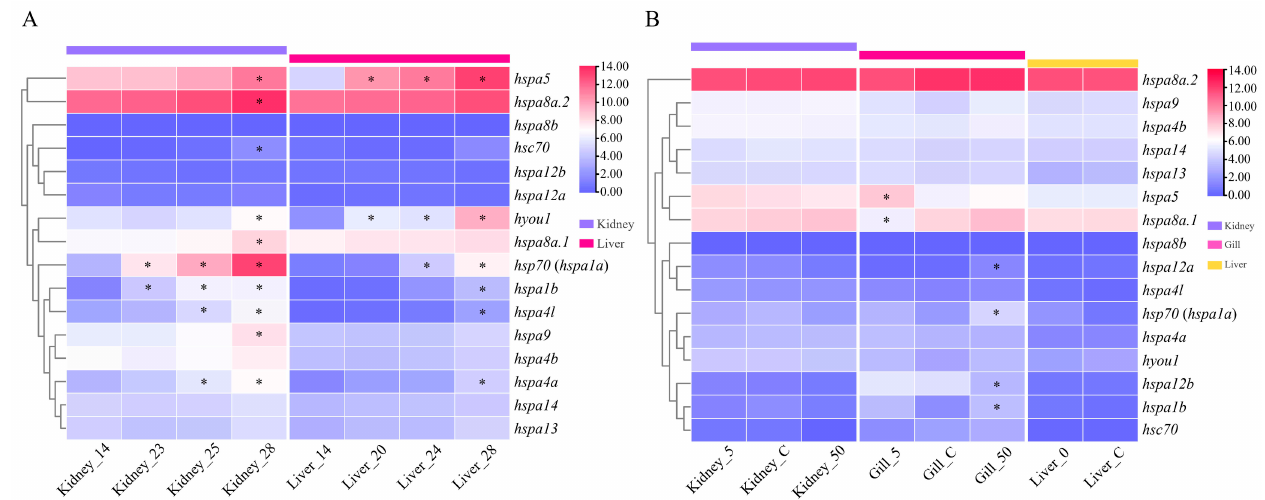
Figure 6. Expression patterns of HSP70 genes under abiotic stresses in S. maximus . ( A ) Expression patterns of HSP70 genes in kidney and liver tissues under heat stress. Control group: 14, 14 °C; 20, 23, 24, 25, and 28 represent 20 °C, 23 °C, 24 °C, 25 °C, and 28 °C heat stress groups, respectively. ( B ) Expression patterns of HSP70 genes in kidney, gill, and liver tissues under salinity stress. C: 30‰ (natural seawater); 50: 50‰; 5: 5‰; 0: 0‰ (fresh water). Cells with different colors correspond to different expression levels, which were normalized into log 2 (TPM + 1). * indicates differentially expressed (or significantly up- or downregulated) HSP70 genes with |log 2 fold change (FC)| > 1 and false discovery rate (FDR) < 0.01.